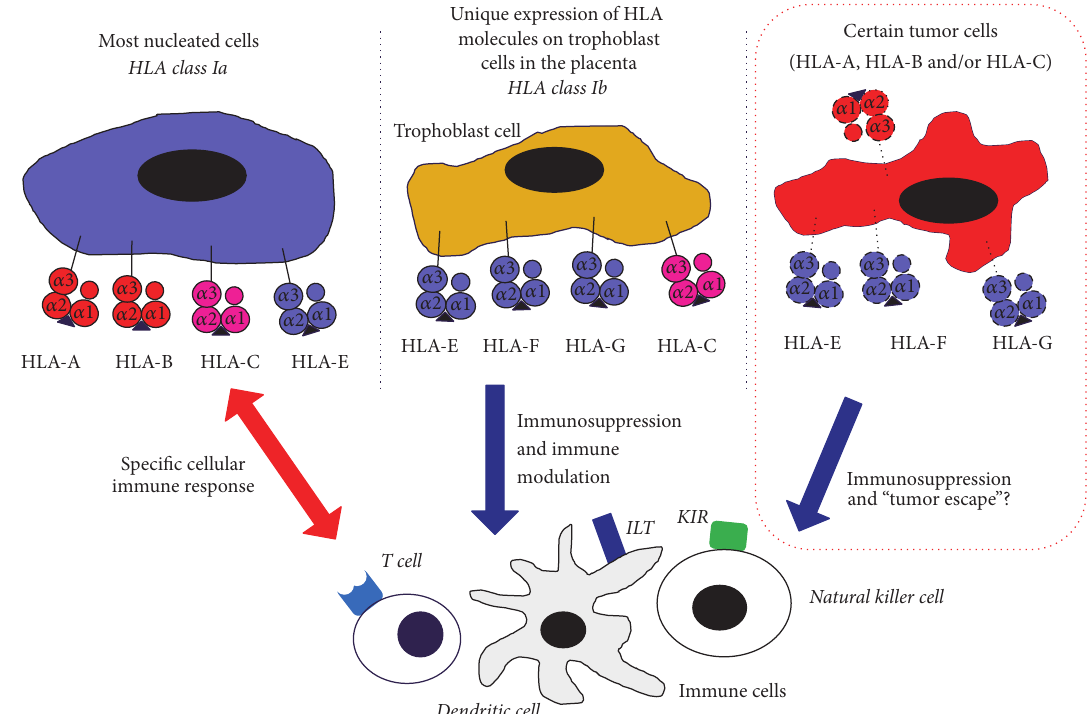
Figure 1: In some cases, tumor cells, for example, malignant melanoma cells, may obtain through selection processes an HLA expression profile that in varying degrees mimics the HLA expression on extra-villous trophoblast cells at the fetomaternal interface during pregnancy. The specific HLA expression profile on tumor cells involving one or several of the HLA class Ib molecules may be one mechanism leading to immunosuppression and immune escape (ILT: immunoglobulin-like transcript; KIR: killer-cell immunoglobulin-like receptors).